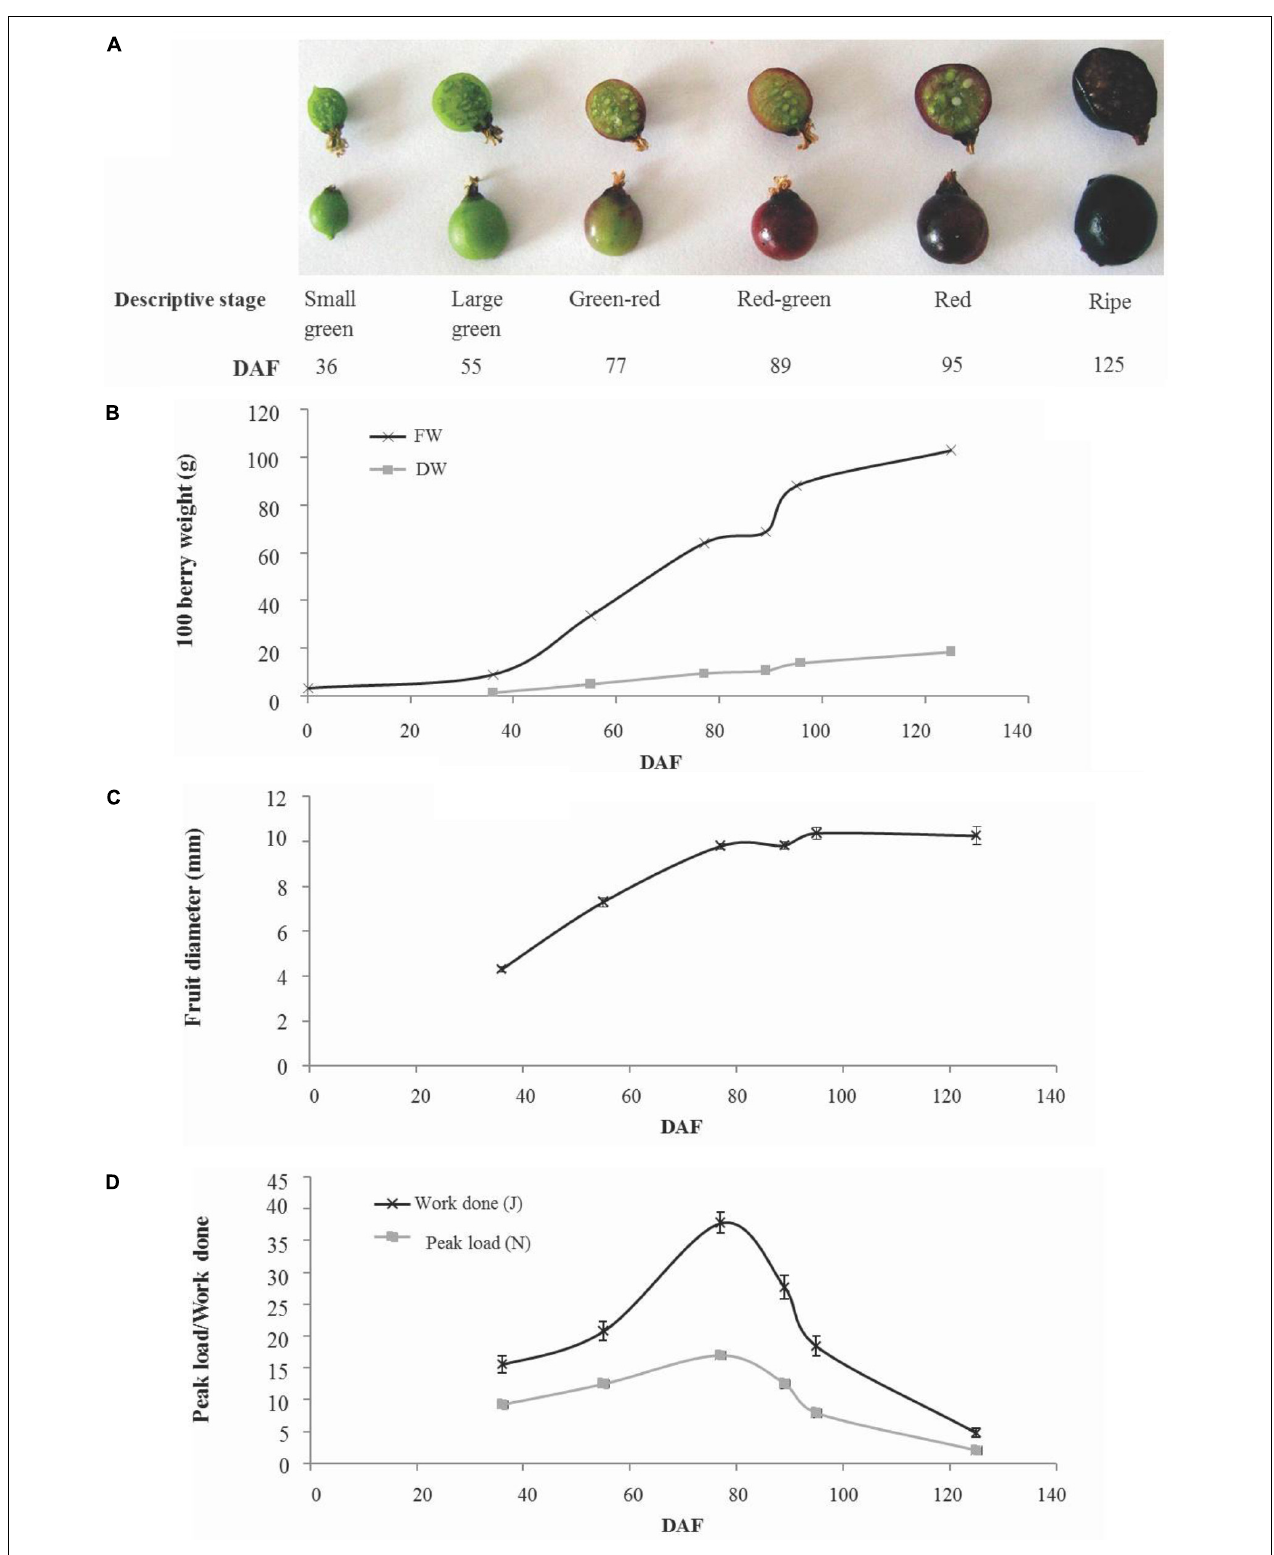
FIGURE 1 | Developmental phenotype of blackcurrant fruit. Representative fruit harvested at numbered days after flowering (DAF) of six descriptive stages are illustrated (A) . The fresh and dry weight of flowers and fruit were recorded for 100 fruit (B) and the mean fruit diameter ( n = 13) was measured and is indicated ± SE (C) . Fruit firmness (D) was estimated as the peak load required or total work done to compress whole fruit by 20% and is indicated as mean ± SE ( n = 13).